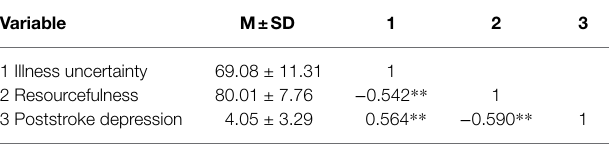
TABLE 3 | Correlations among illness uncertainty, resourcefulness, and